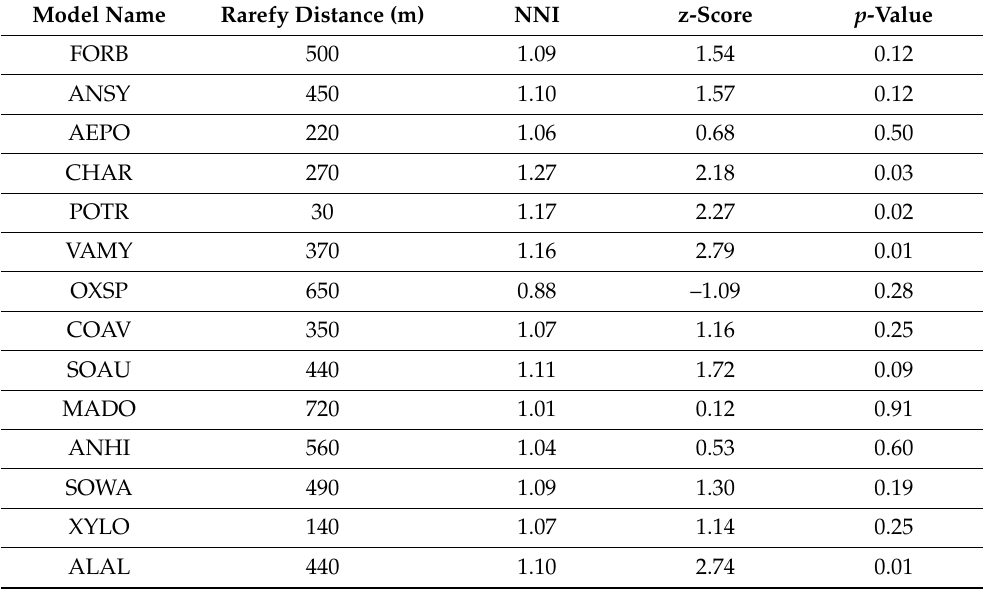
Table A1. Check for spatial clustering with the average nearest neighbour index (NNI), its z-score, and p -level for 14 brown bear food-probability models in the Central Forest State Nature Reserve